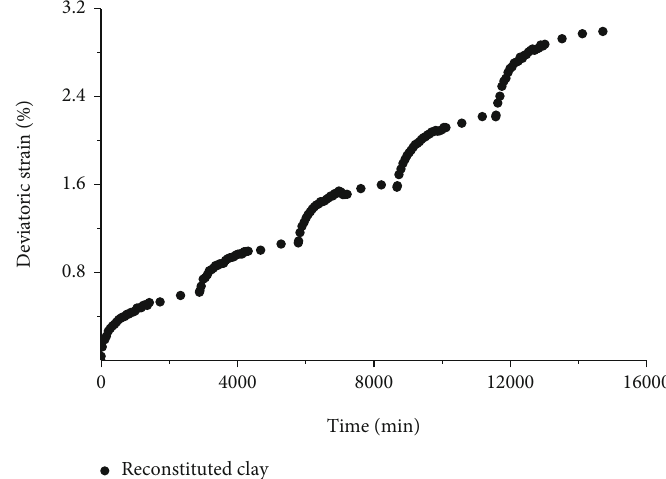
Figure 6: Whole process curve of triaxial deviatoric strain evolution of reconstituted